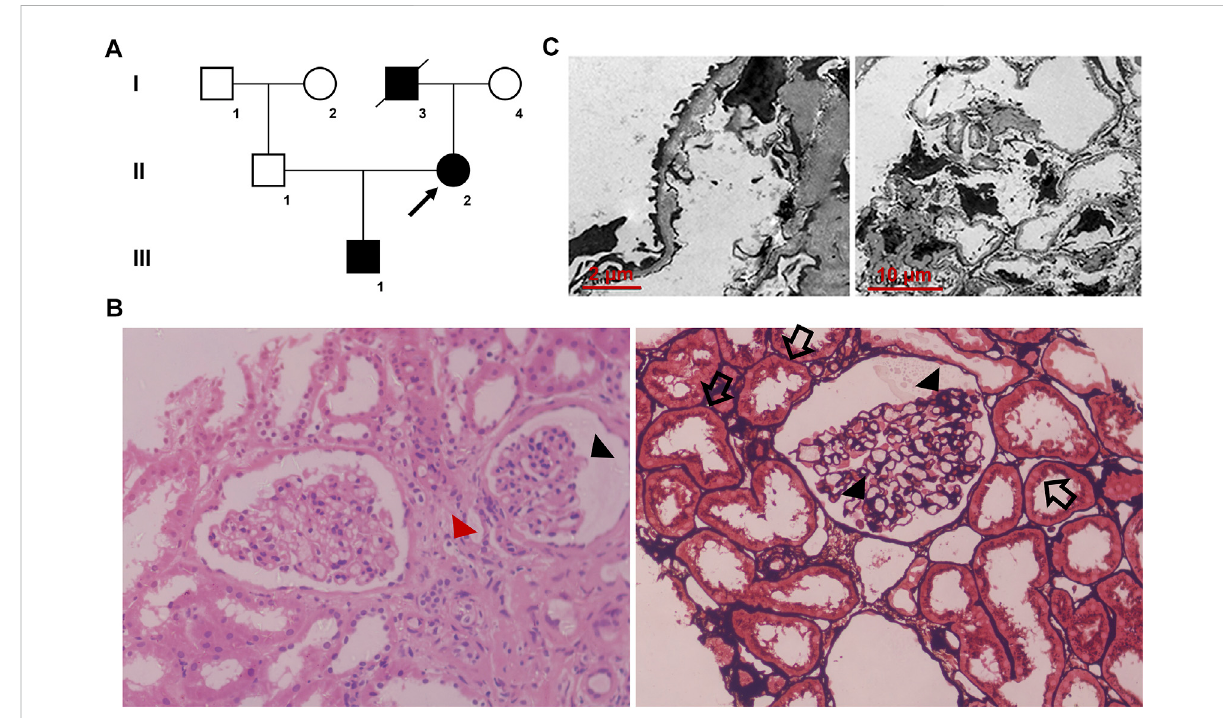
FIGURE 1 (A) Pedigree of the family. Family members are identi fi ed by generations and numbers. Squares = men; circles = women; black symbols = individuals with (C) 853G > Amutation;andarrow=theproband (B) Histopathological fi ndingsoftheproband.Lightmicroscopyimages(40×) display focalsegmentalglomerulosclerosis(blacktriangles)andswollenorgranulatedtubularepithelialcells(blackarrows),aswellasscatteredfoamcellsin the interstitium (red triangle) (C) Transmission electron microscopic images display a few round and electron-dense bodies in the mesangial insertion. The glomerular capillary wall is diffusely thickened, and the GBM thickness is irregular with an uneven density. There is characteristic combined diffuse effacement of foot processes. GBM, glomerular basement